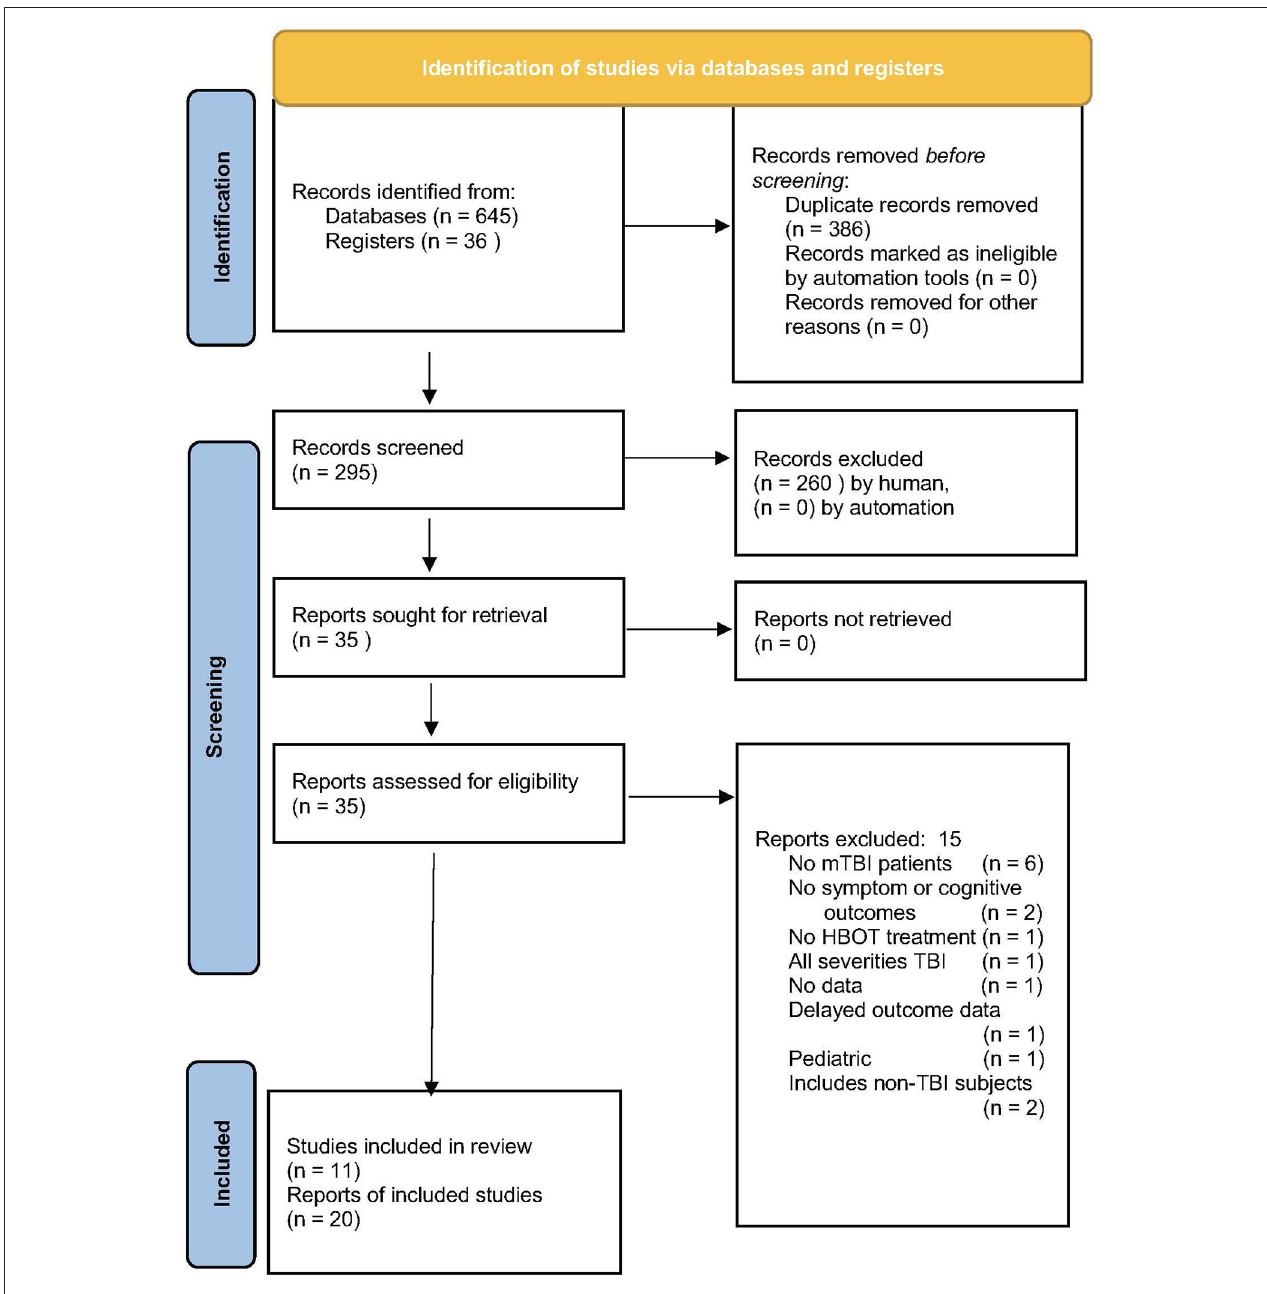
FIGURE 1 | PRISMA flow chart of article search and retrieval (108).